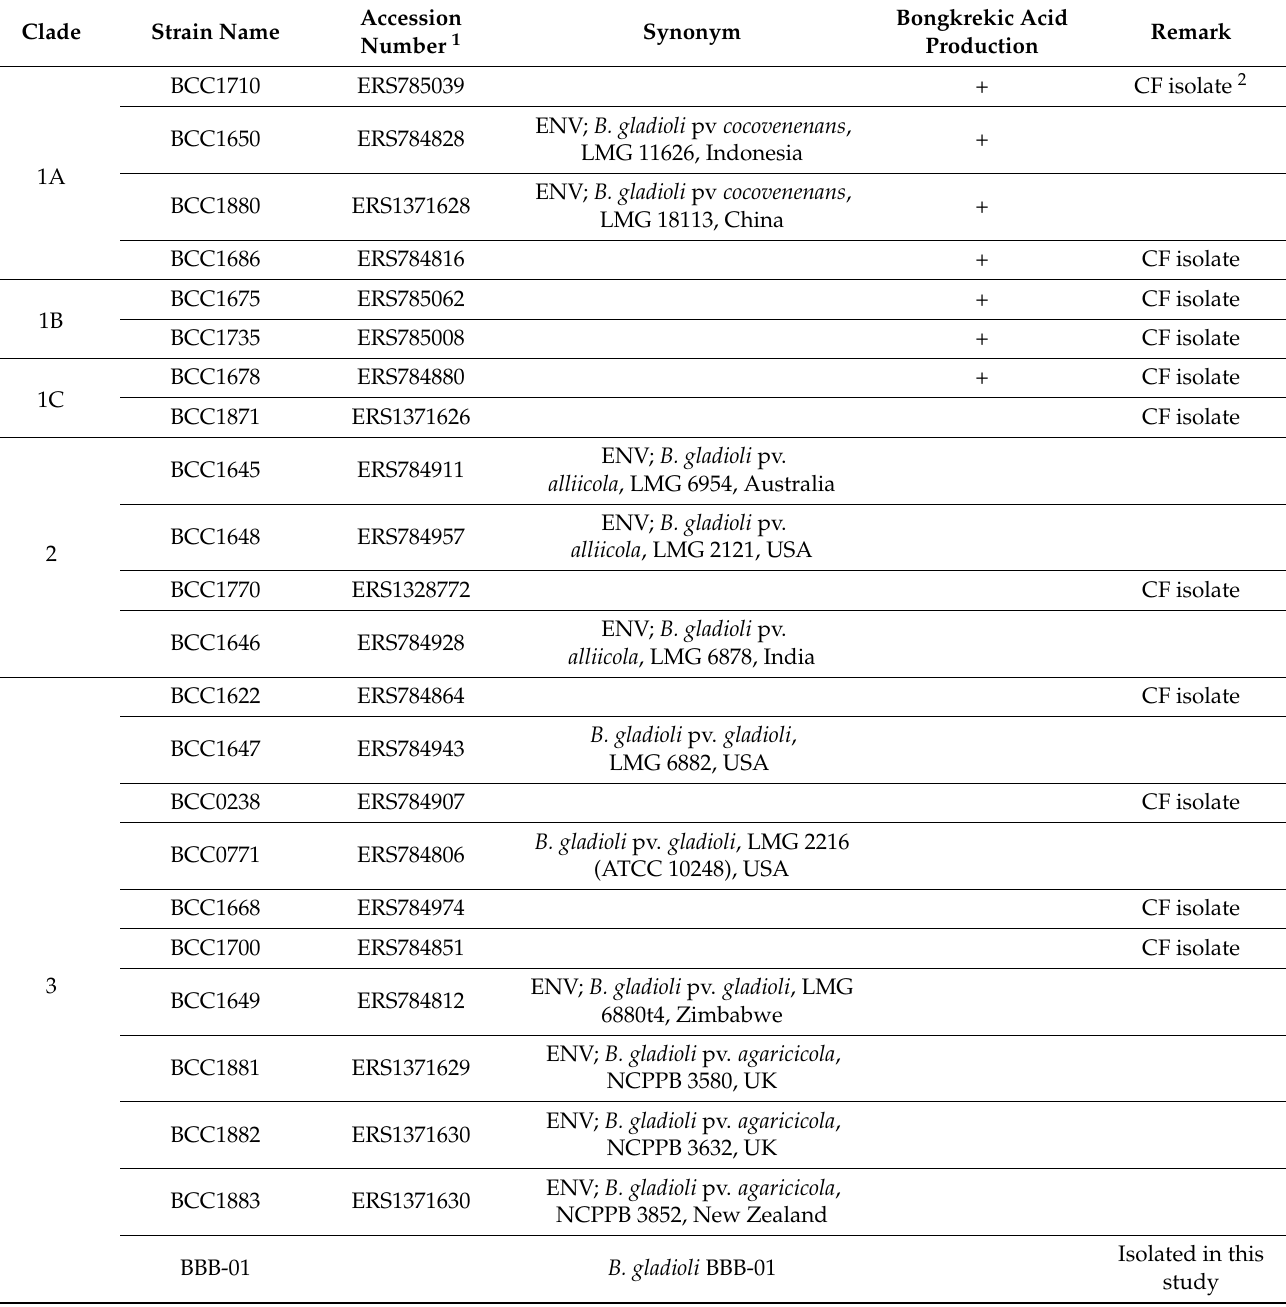
Table 1. Burkholderia gladioli isolates selected in the pangenome analysis in this